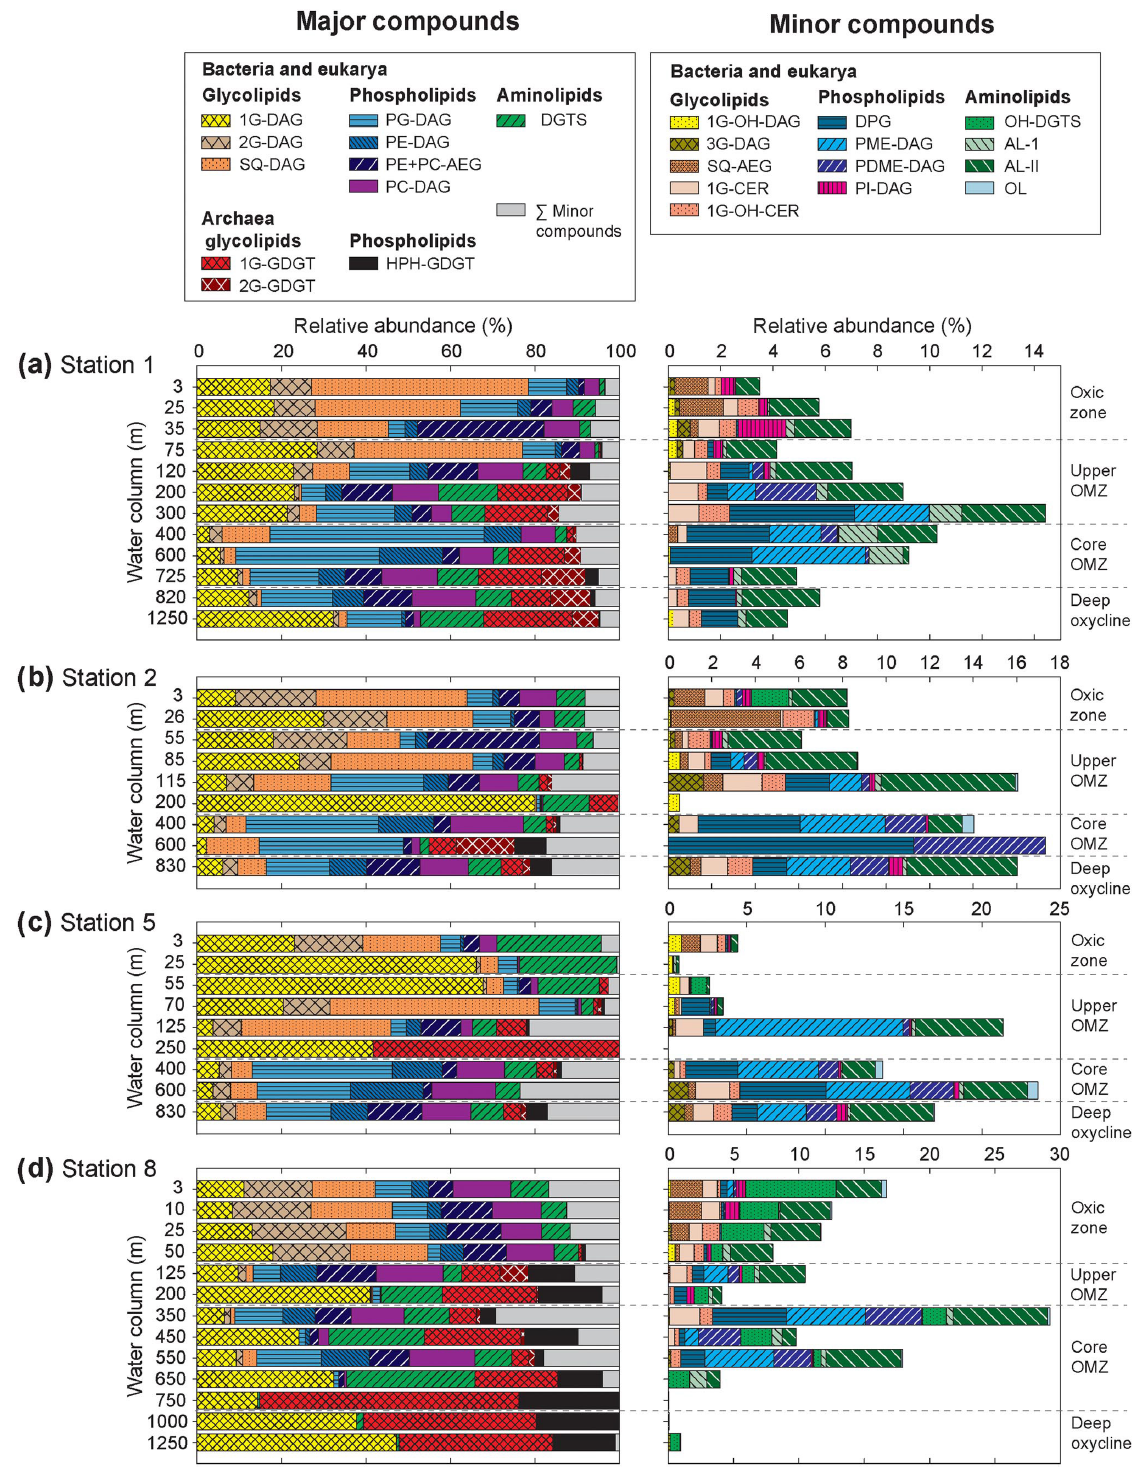
Figure 4. Relative abundance of (a) major and (b) minor IPLs at sampled depths of Stations 1, 2, 5 and 8 in the ETNP. Major IPLs are defined as those comprising more than 10% of total IPLs (minor compounds comprised less than 10%) at more than one depth horizon at the four stations. Also depicted are the different geochemical zones in the water